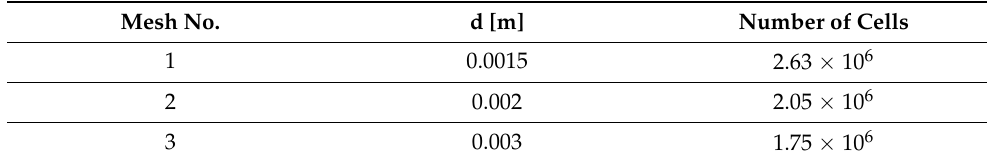
Table 5. Mesh cell size d and number of cells. Mesh